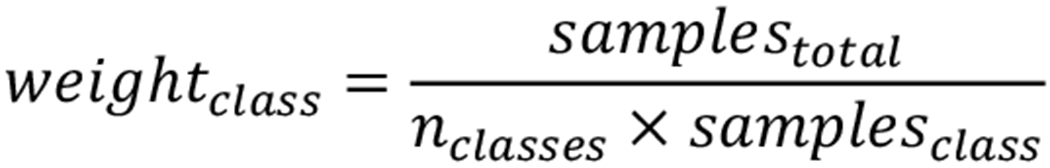
Weighting of classes